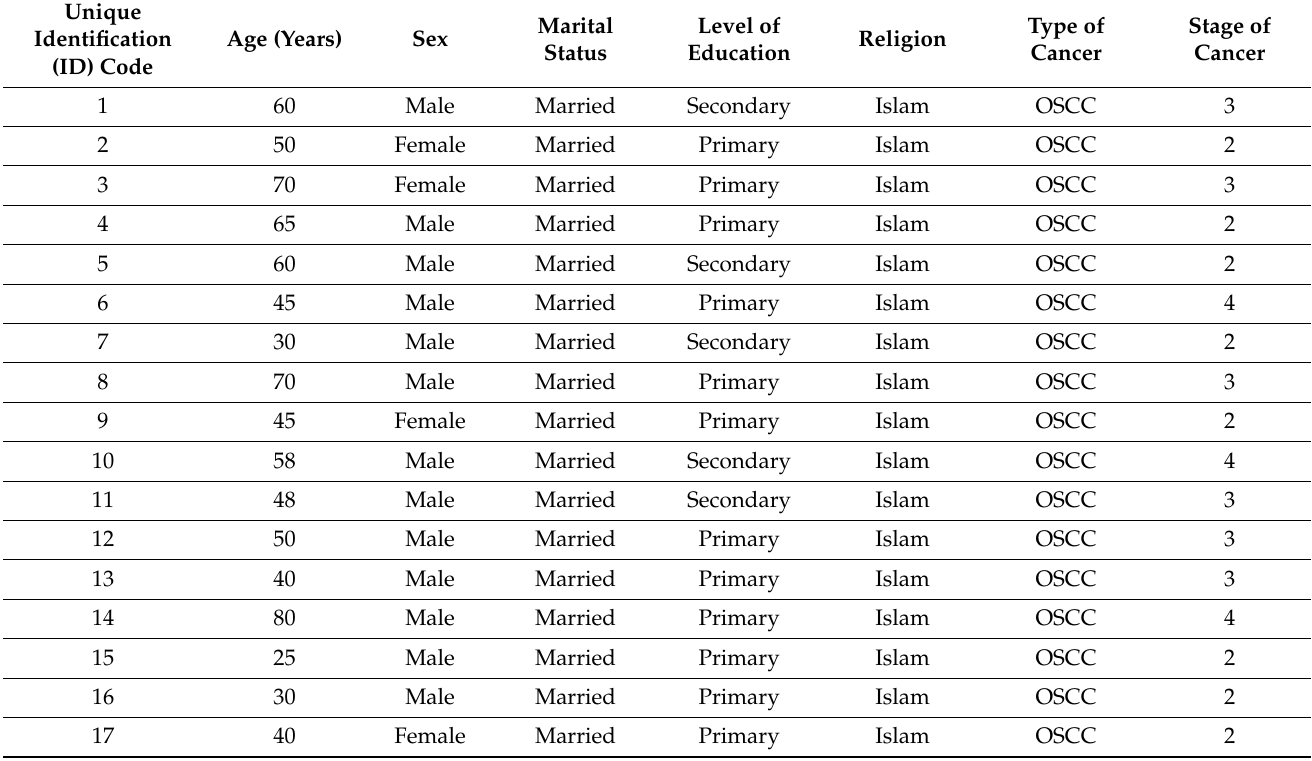
Table 1. Demographic characteristics of